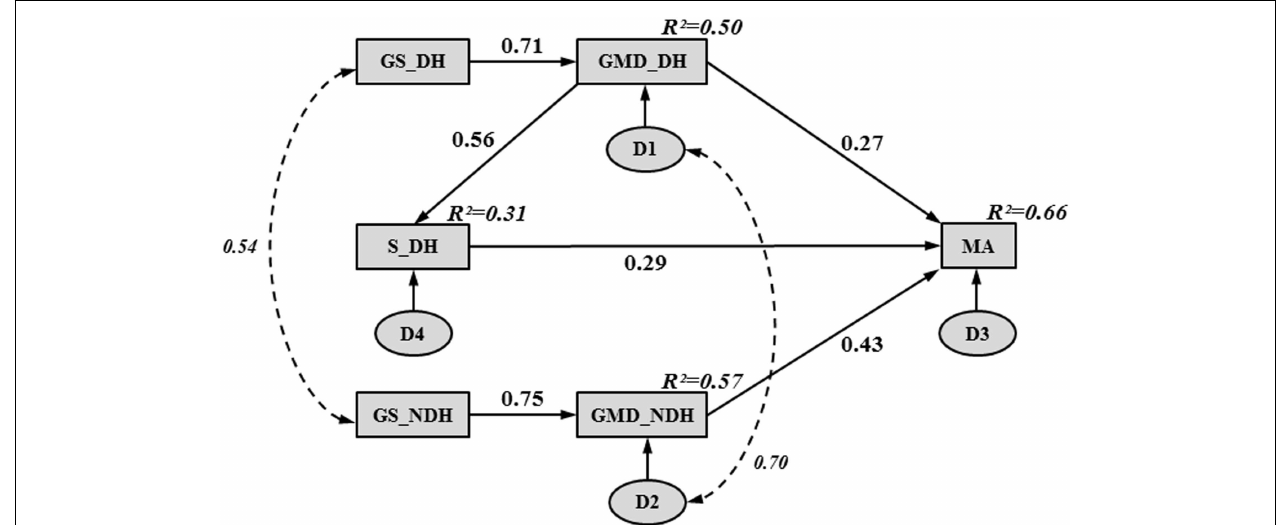
coefficients. Numbers in the upper right-hand corner of each rectangle represent squared multiple correlations ( R 2 ) (i.e., proportion of the variance in the dependent variable accounted for by the set of independent variables).The letter “D” inside an oval represents the unobservable disturbance (i.e., measurement error and the variance amount of a dependent variable unexplained by the predictors) associated with each dependent and mediating variable.